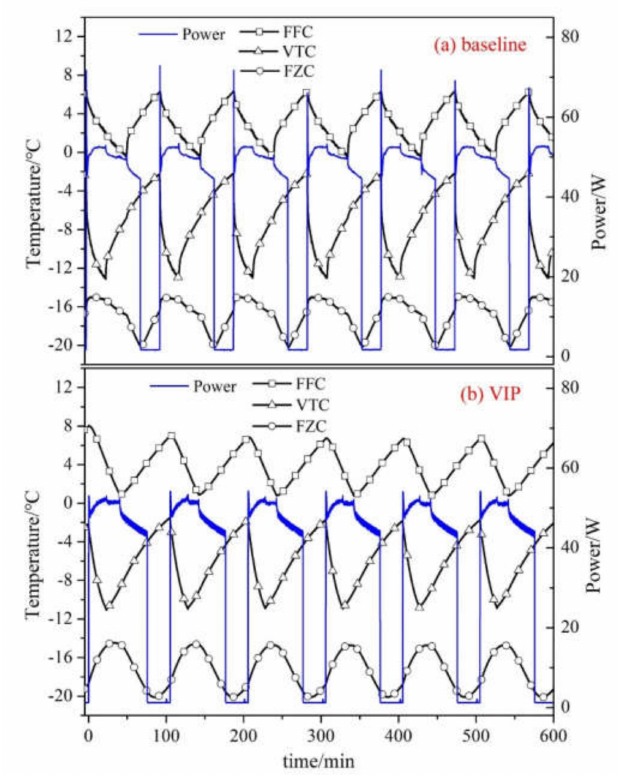
Figure 3. Steady cyclic operations of the refrigerator: ( a ) baseline case; ( b ) VIP case. (VIP means vacuum insulation panel as defined in the